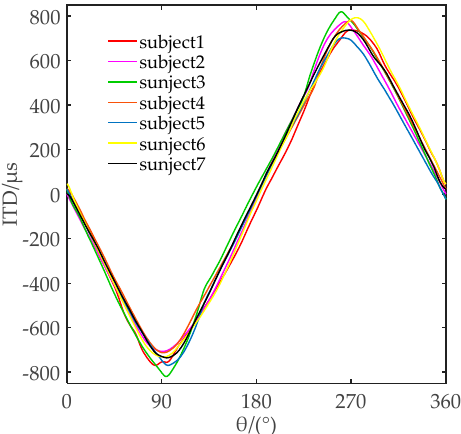
Figure 3. ITD contrast of different subjects in a same direction. X-axis denotes the azimuth of the sound source, Y-axis denotes the ITD value, and curves in different color denote the ITD variation trends of different subjects.